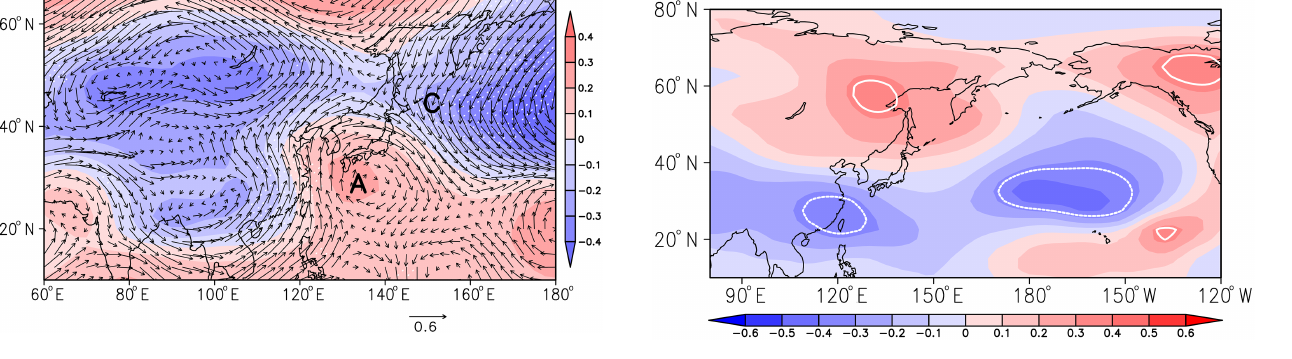
Figure 9. The CC between predictor x 4 and Z500 DY in winter from 1980 to 2013. The white curves indicate that the CC exceeded the 95% confidence level.